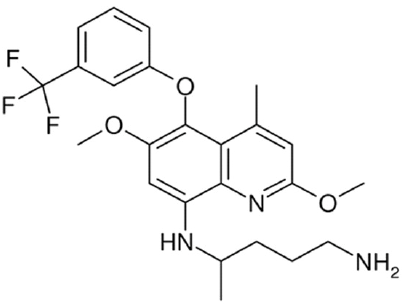
Figure 1. Structure of tafenoquine.